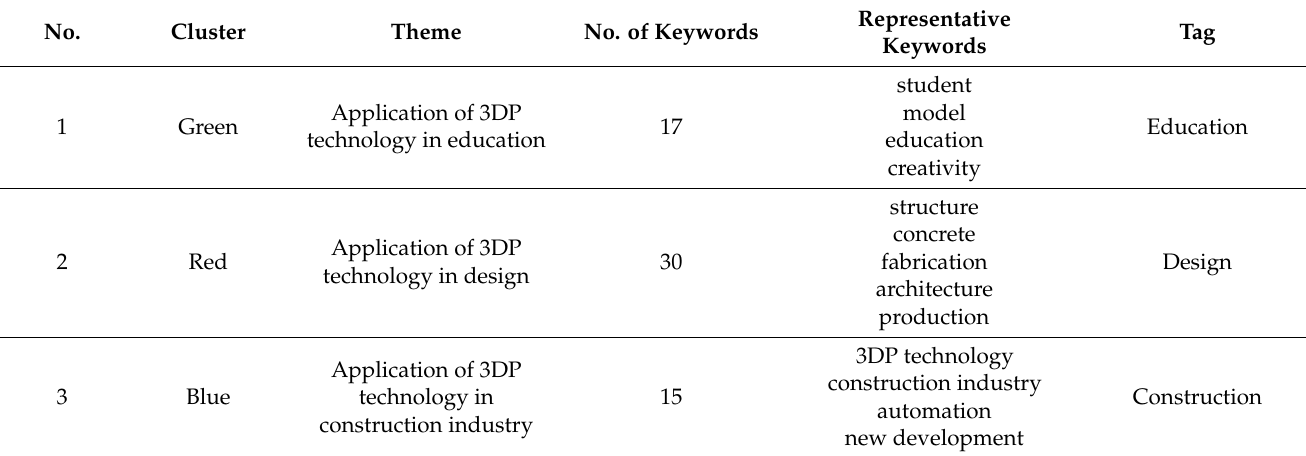
Table 4. Clusters and themes in the analyzed literature